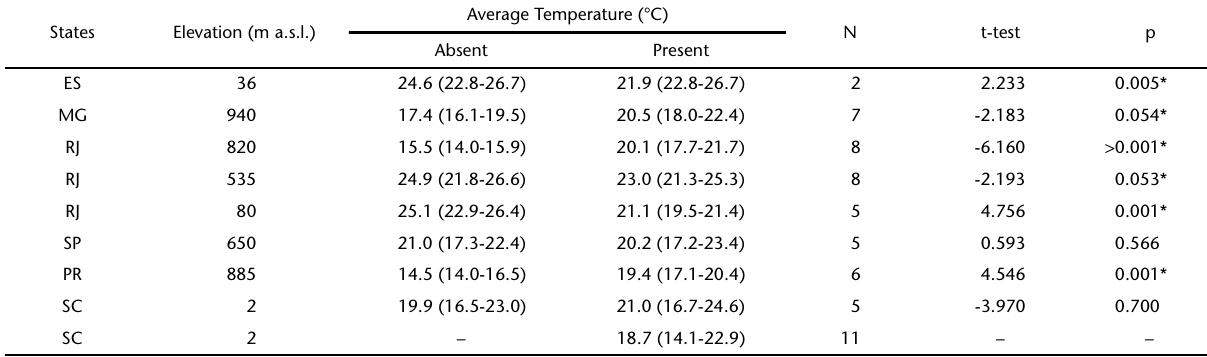
Table III. Temperature (average value and variance) in sites in different states and at different elevations, where Pygoderma bilabiatum was present of absent, number of months when the species was captured (N) and t test results. States Elevation (m